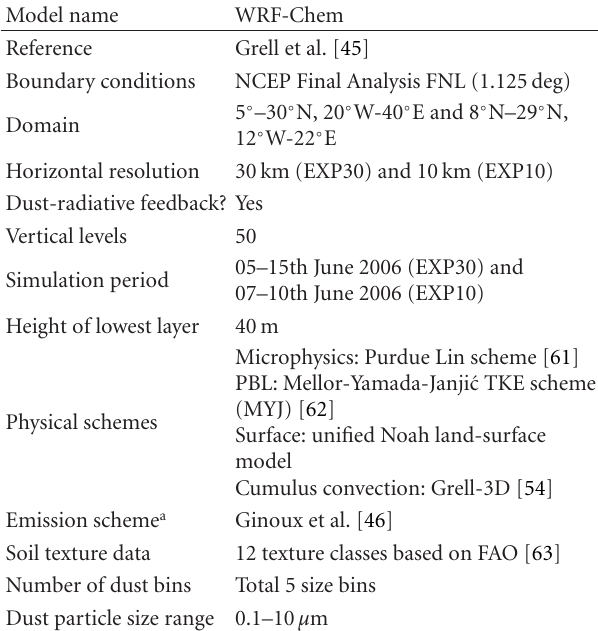
Table 1: Model configuration used for experimentation.